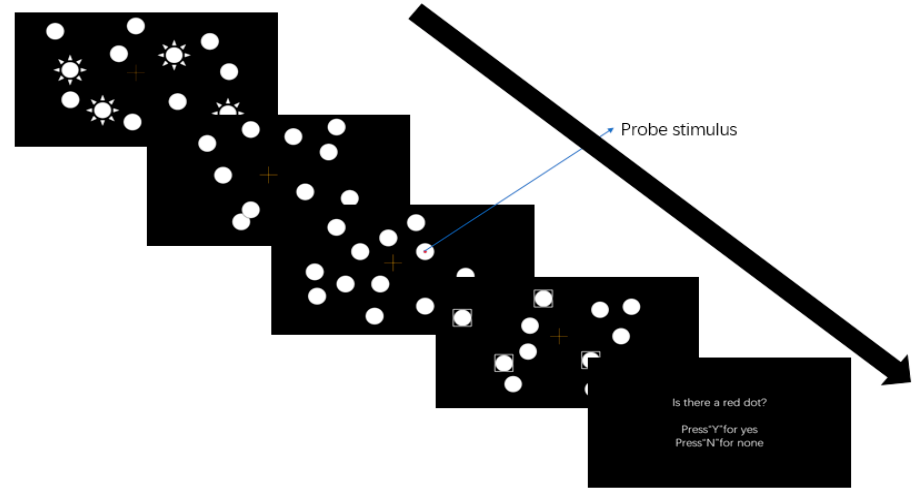
Figure 2. Diagram of the related test procedure.